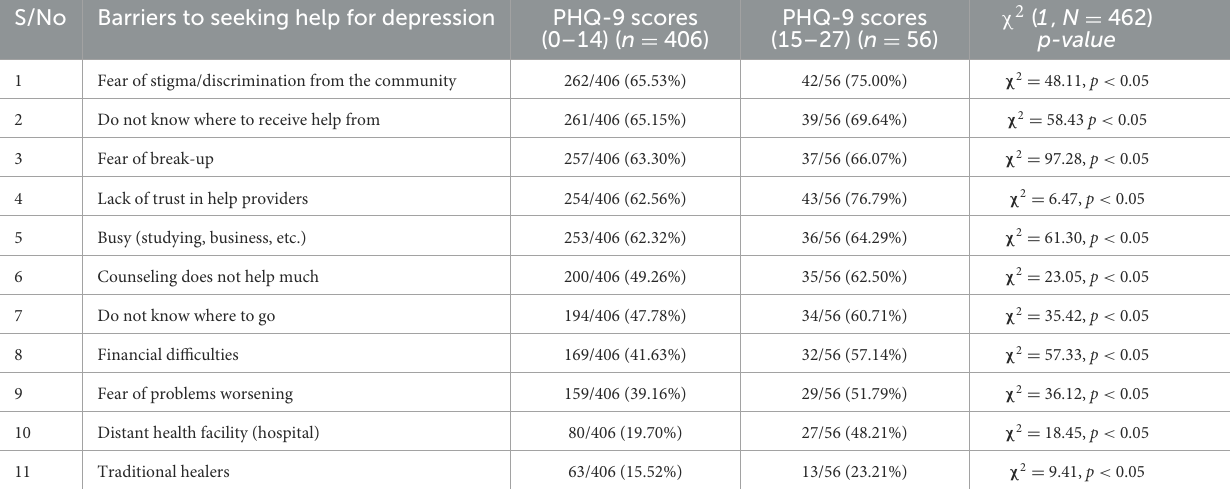
TABLE 4 Perceived barriers to seeking help for depression stratified by scores 0–14 and 15–27 on